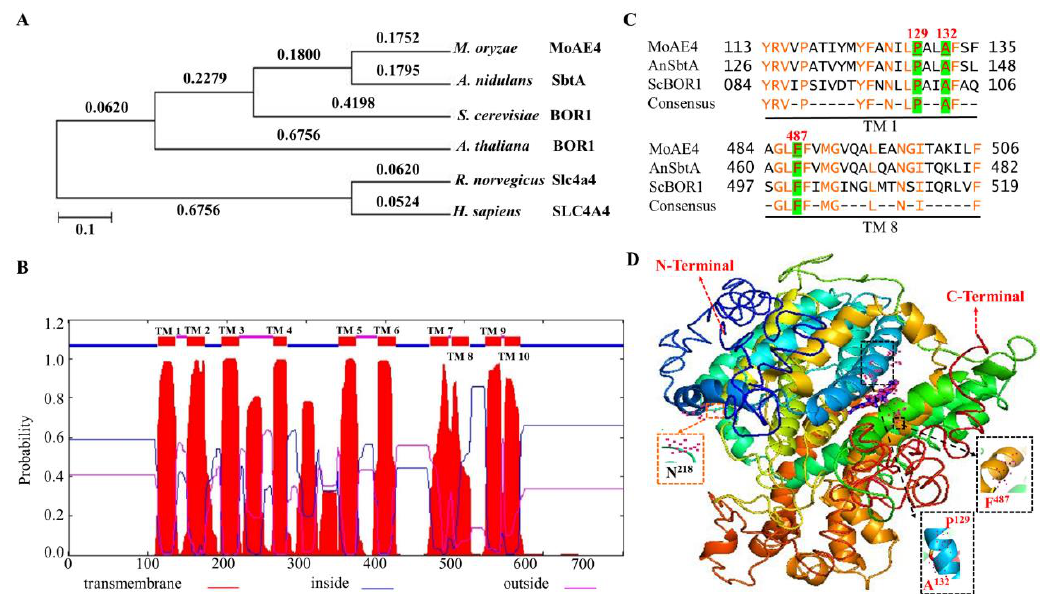
Figure 1. Structure of the MoAE4 and phylogenetic analysis. ( A ) Phylogenetic tree. It was constructed with reported anion exchange protein 4 homologs from M. oryzae , A. nidulans , S. cerevisiae , A. thaliana , R. norvegicus , H. sapiens , indicating that MoAE4 has a relatively close relationship with the fungal group. ( B ) TMHMM posterior probabilities for WEBSEQUENCE (on-line analysis). A schematic diagram of the MoAE4 protein transmembrane domain of M. oryzae is shown indicating the 10 transmembrane domains and marked the amino acid inside and outside the membrane. ( C ) Sequence alignment. The transmembrane domain 1 and 8 of MoAE4 was compared with closely related to the fungal group A. nidulans SbtA gene and S. cerevisiae BOR1 gene. ( D ) Tertiary structure (3-D). The structure was predicted using the web-based server I- TASSER that shows the ligand binding site residues of transmembrane domain P 129 , A 132 , and F 487 . The active site residue is N 218 .